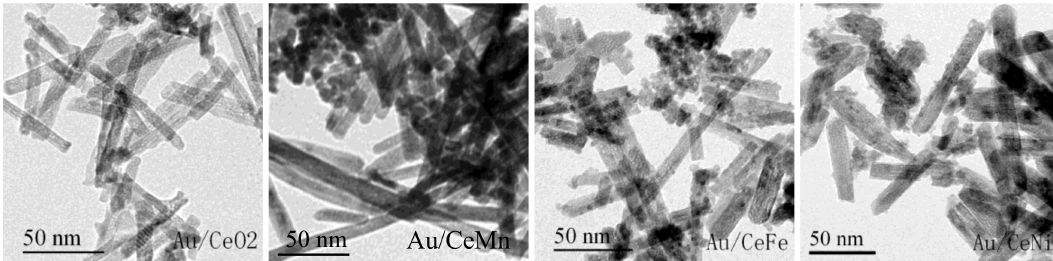
Figure 2. TEM images of Au catalysts supported on CeO 2 and CeM mixed oxides with different dopants (Au/CeO 2 ; Au/CeMn; Au/CeFe; Au/CeNi).